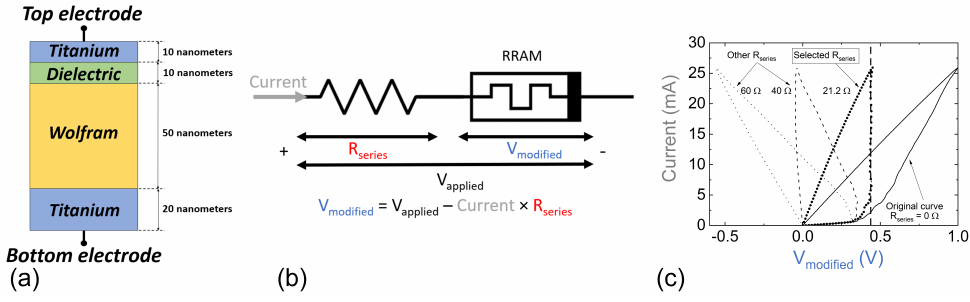
Figure 1. ( a ) RRAM structure cross-section. ( b ) Circuit scheme to explain the different voltages employed in this work. ( c ) Current versus modified voltage for different series resistances. We choose the curve with the maximum slope (in fact, it is a vertical region, shown in symbols) as the one that allows us to extract the correct series resistances, as depicted in [18].